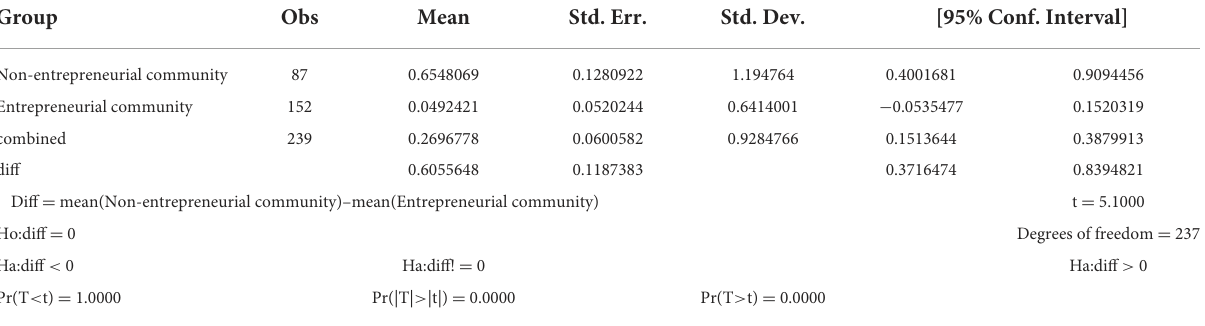
TABLE 5 T test results of the growth rate of the proportion of entrepreneurial population in the community. Group Obs Mean Std. Err. Std. Dev. [95% Conf. Interval]